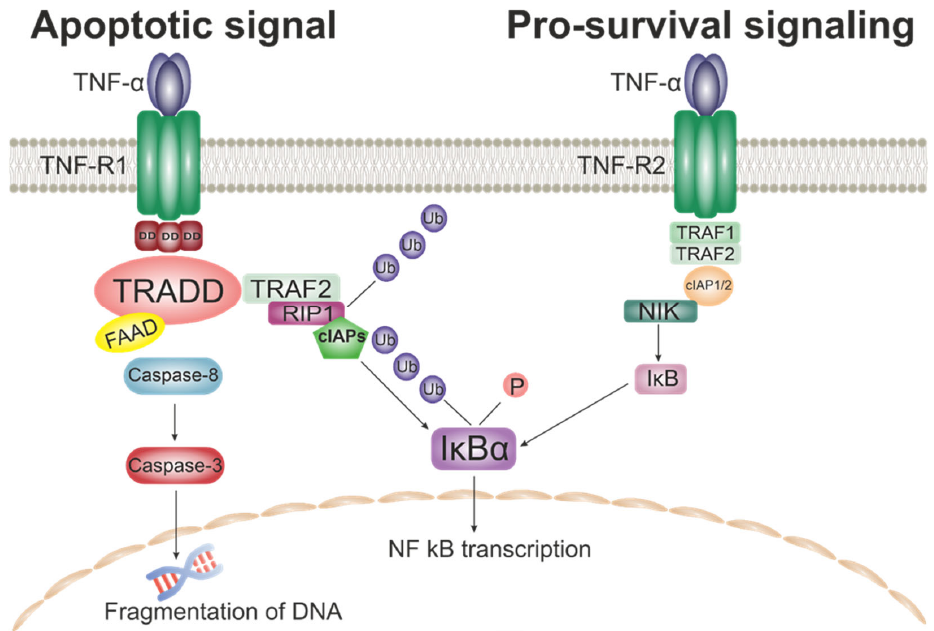
Figure 3. Possible options for transmitting a signal of TNF to the cell.